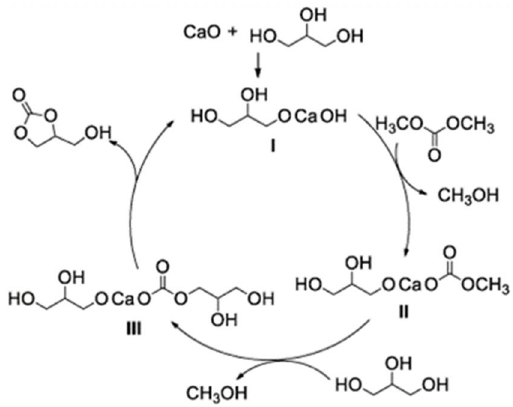
Figure 4. A plausible reaction mechanism for converting glycerol to glycerol carbonate using CaO catalyst [87], open access journal of Catalysts. catalyst [87], open access journal of